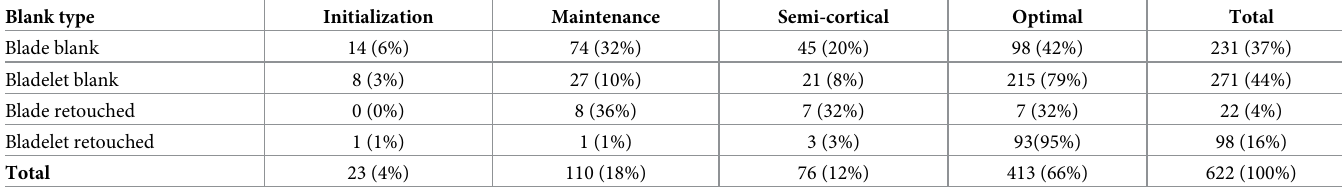
Table 1. Distribution of blades and bladelets according to blank type, presence of retouch, and the identified reduction phase. The category initialization contains all blanks deemed to have had a role in the core’s shaping-out (e.g., fully cortical and crested blanks), while the category maintenance lumps all blanks related to the re-organi- zation of the core convexities and maintenance of optimal flaking angles (e.g., lateral blades, neo-crested blanks, and technical blanks). The category semi-cortical includes blanks with different frequencies of cortex covering the dorsal face, while the category optimal contains all blanks with 0% cortex believed to have been obtained during the optimal reduction stage. Rounded percentages are given in